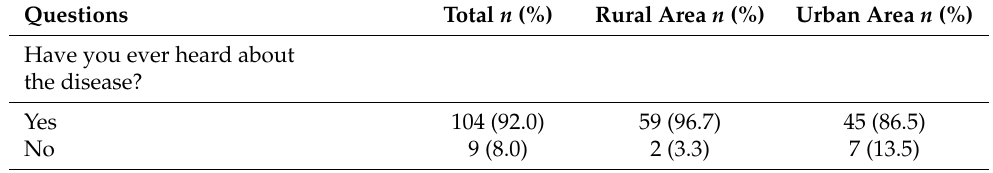
Table 3. Knowledge about rabies, total and stratified by residential area, Cear á , Brazil ( n =